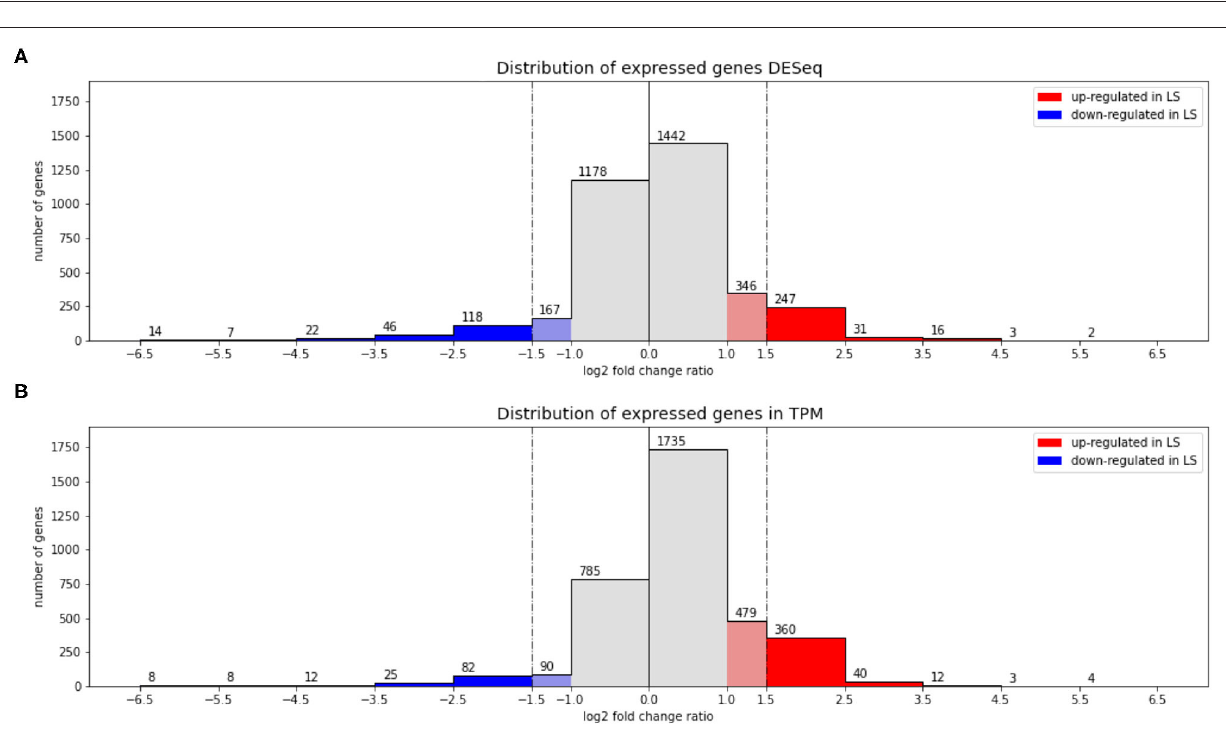
two genes in the cytochrome bd ubiquinol oxidase cluster cydAB (HELO_2456-7). Among the genes involved in amino acid metabolism, those upregulated on acetate include: putA (HELO_1802) coding for bifunctional proline